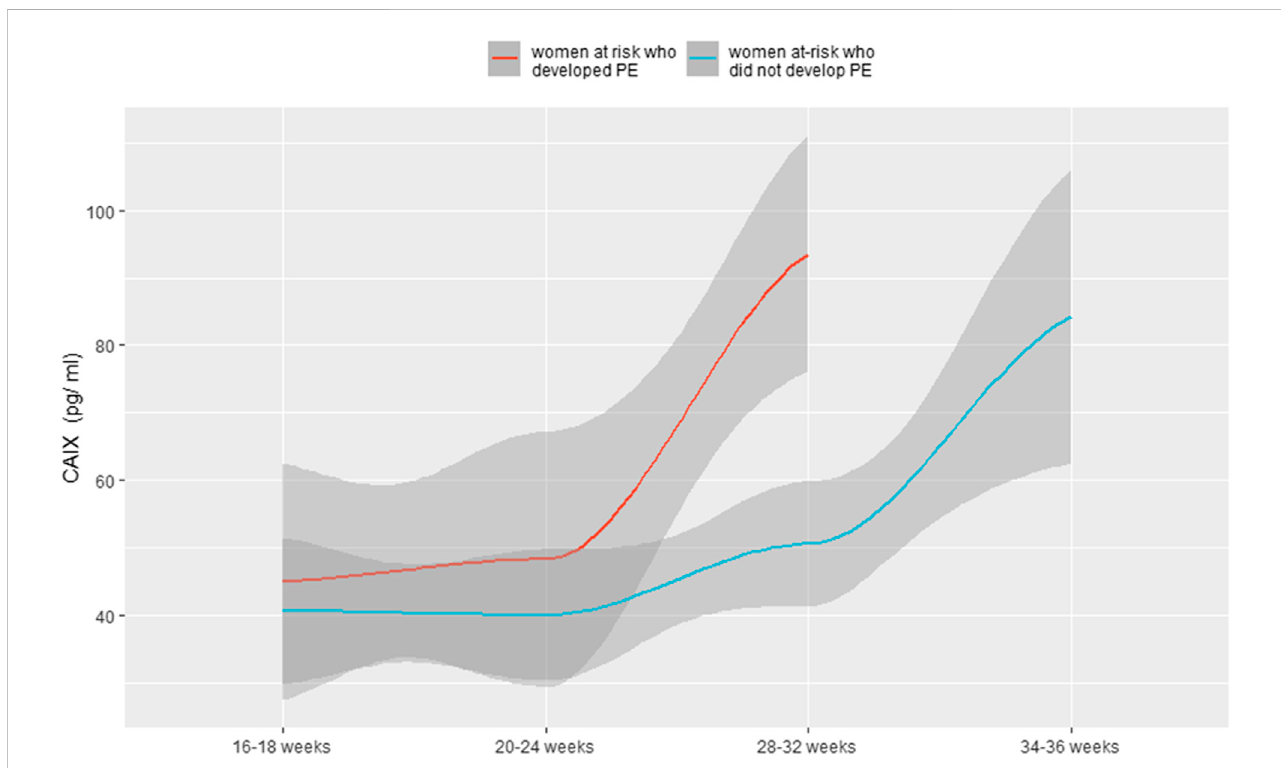
FIGURE 2 Levels of CAIX as a function of gestational time for both women at risk who did not develop PE and women at risk who developed PE.